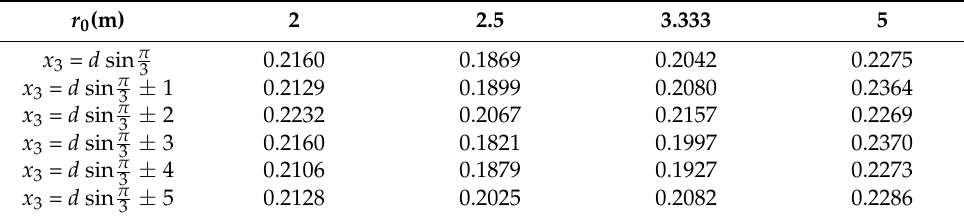
Table 3. Error ( ε / d ) analysis for different tetrahedron bases (“ x ” coordinate of AN 3 ). r 0 (m)